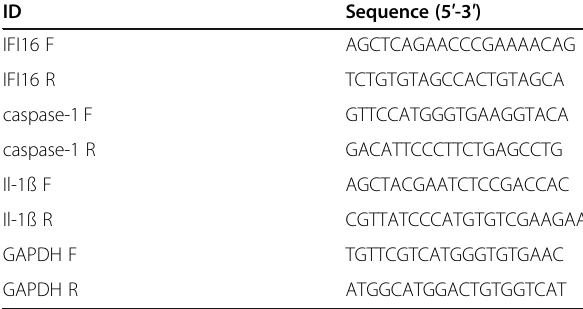
Table 2 Primers ’ sequences used in qRT-PCR in this